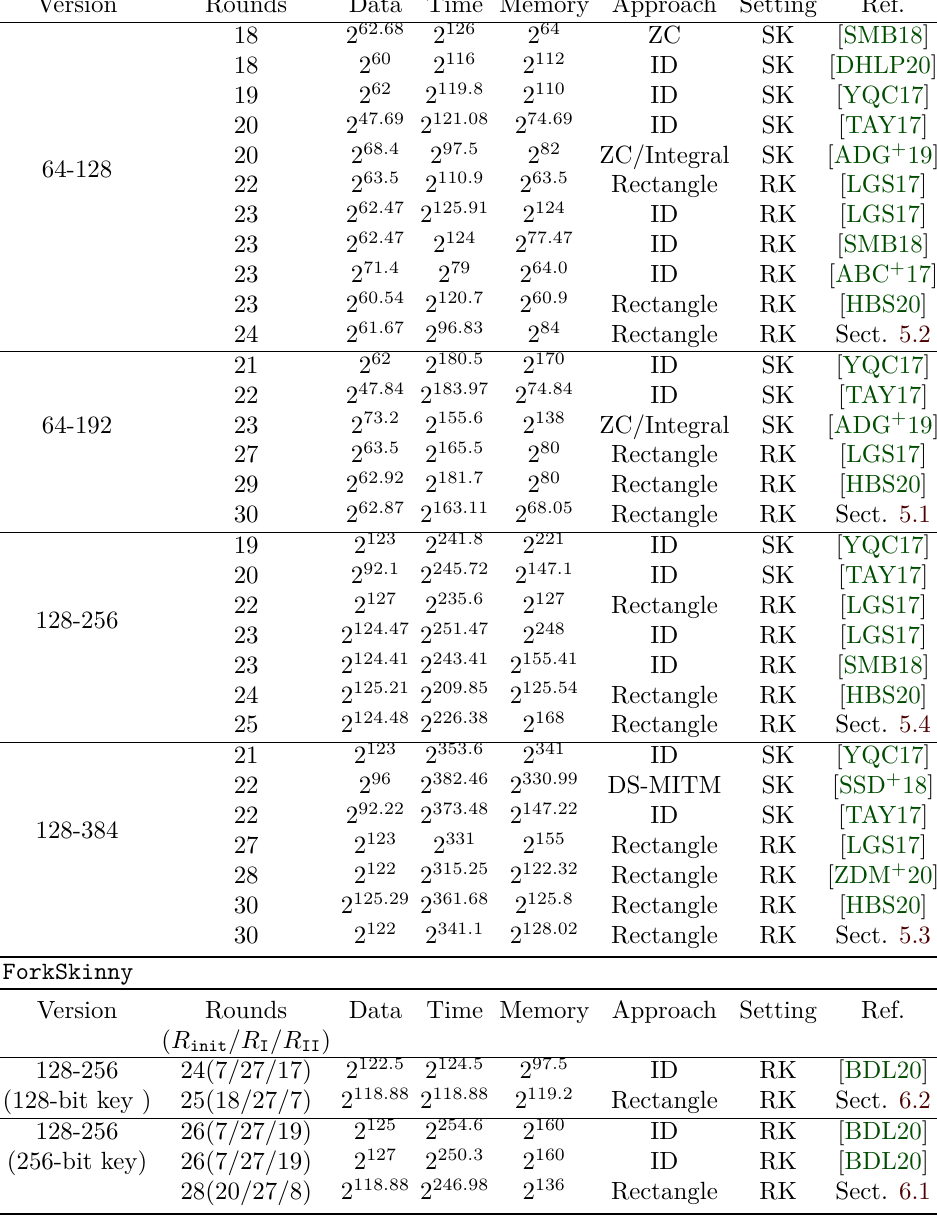
Table 1: Summary of cryptanalytic results on SKINNY and ForkSkinny , where ID, ZC and DS-MITM denote impossible differential, zero correlation and Demirci-Selçuk Meet-in-the- Middle cryptanalysis. SK and RK denote single-key and related-key settings,